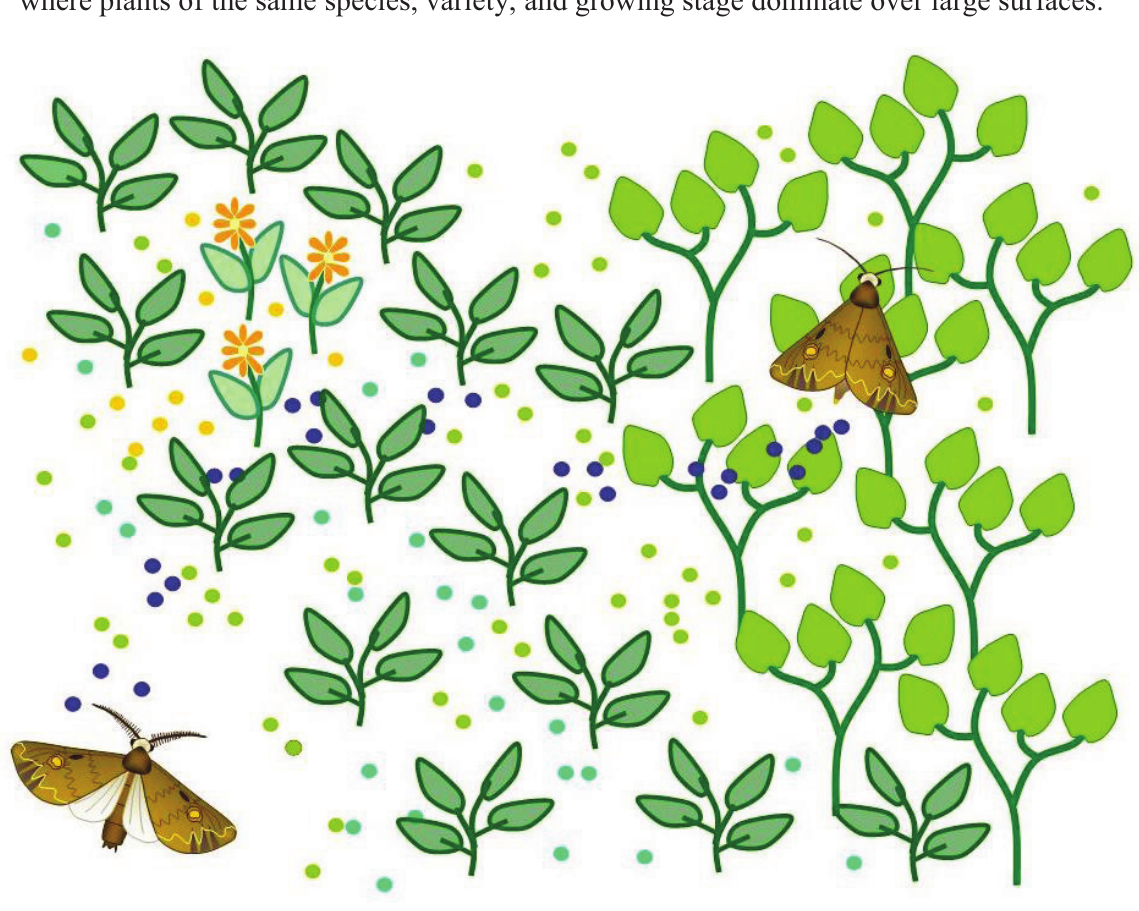
Figure 1. Orientation of male moths towards the female-emitted sex pheromone in a natural environment. The pheromone (blue) is emitted in small amounts from a point source, an isolated female, whereas flower and green leaf volatiles (yellow and green) from host and non-host plants are highly variable and are often emitted in large amounts and from multiple sources. Detailed physical models for such complex signal combinations are missing but we can extrapolate that they result in a meandering but relatively narrow pheromone plume in a more dispersed, but still heterogeneous cloud of diverse plant volatiles. More homogenous clouds are probably found in highly simplified agro-ecosystems where plants of the same species, variety, and growing stage dominate over large